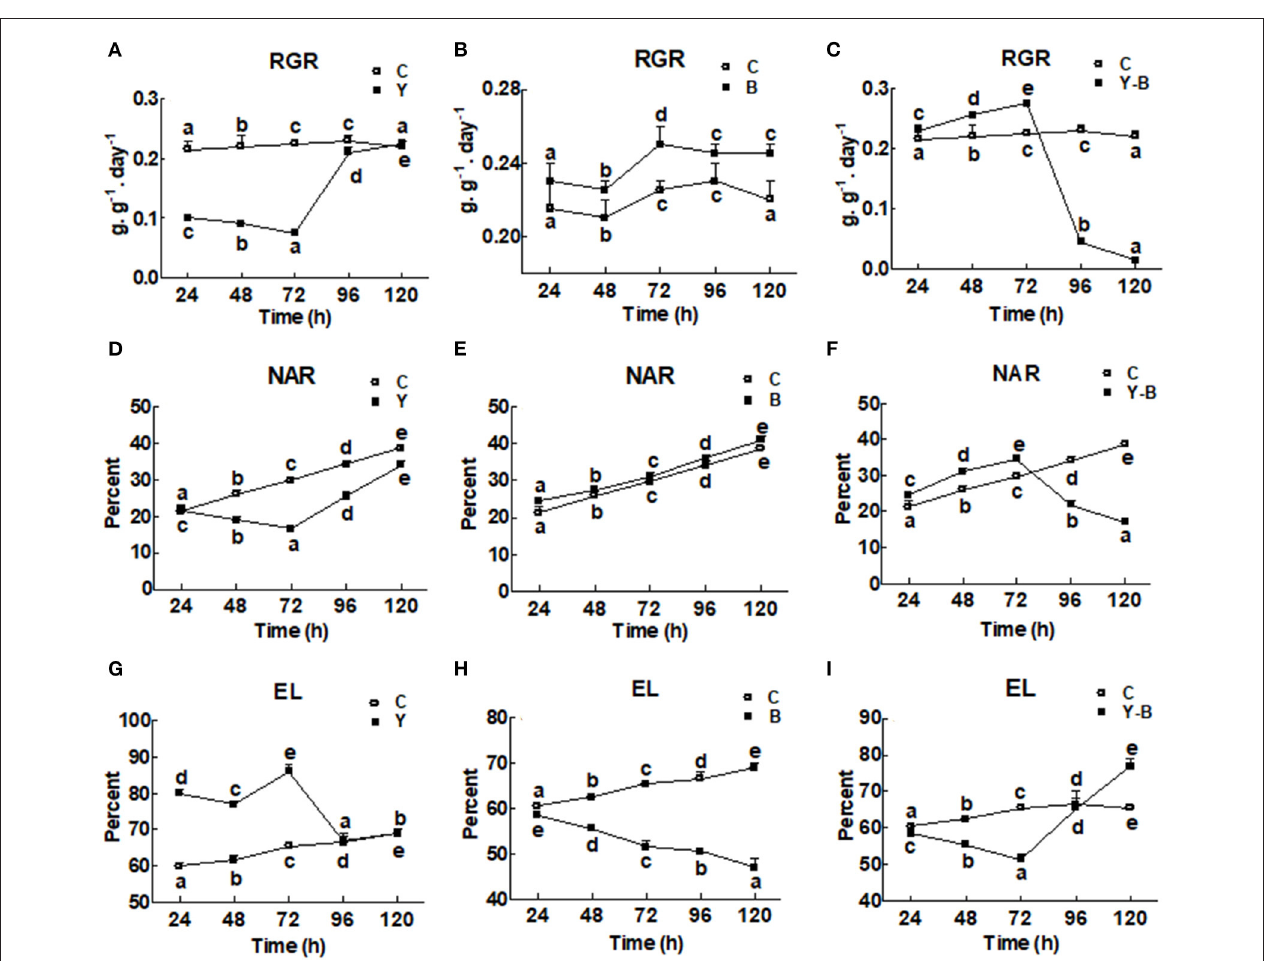
FIGURE 1 | Determination of relative growth rate (RGR; A–C ), net assimilation rate (NAR; D–F ), and electrolytic content leakage (EC; G–I ) in the 11-days-old maize seedlings exposed to different treatments including C (control), Y (yucasin), B ( Bipolaris spp .), Y-B (yucasin- Bipolaris spp.) for the different time duration. Data are mean from three independent experiments with standard error bars. Points on the lines labeled with different letters are significantly different (Duncan test; p < 0.05).